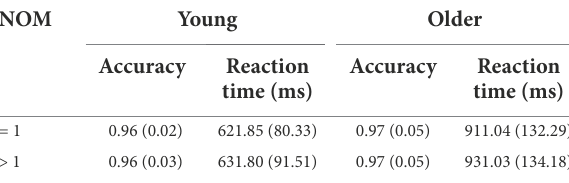
TABLE 4 Descriptive statistics of participants’ lexical decision performance, grouped by age and sublexical ambiguity (i.e.,